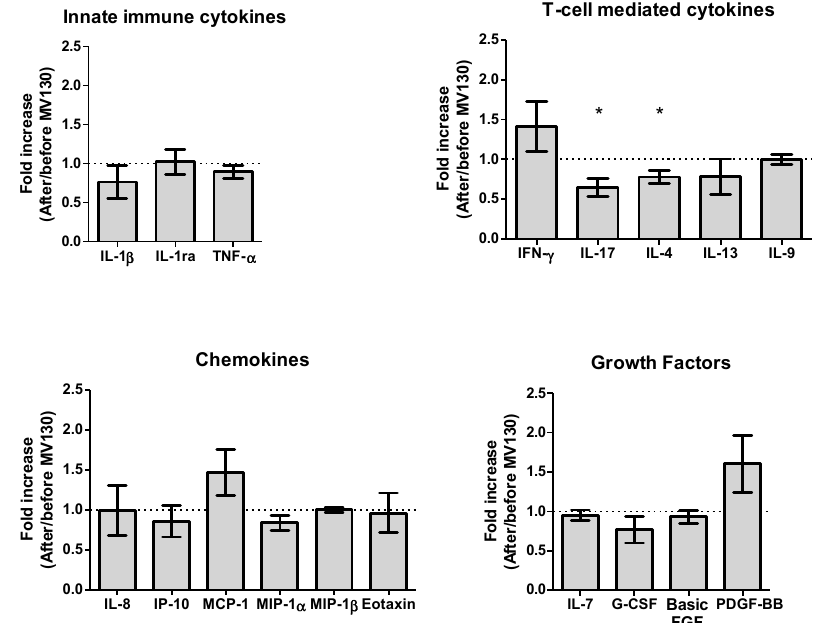
Figure 5. Prophylaxis with MV130 modulates serum cytokine, chemokine and growth factor secretion pattern. Cytokines (upper panels), chemokines (left bottom panel) and growth factors (right bottom panel) secreted in serum one year following MV130 administration determined by Luminex technique. Fold induction relative to basal level (before MV130 treatment) is shown. Undetectable values were found for IL-2, IL-5, IL-10, IL-12(p70), IL-15, GM-CSF, RANTES and VEGF. Data from 9–10 subjects are shown as mean ± SEM of fold increase. Outliers were identified by means of Tukey’s range test on represented values. Normal distribution was evaluated using the Shapiro–Wilk test. p values were calculated using one-sample t -test with a theoretical value of 1 (no fold induction). * p < 0.05.